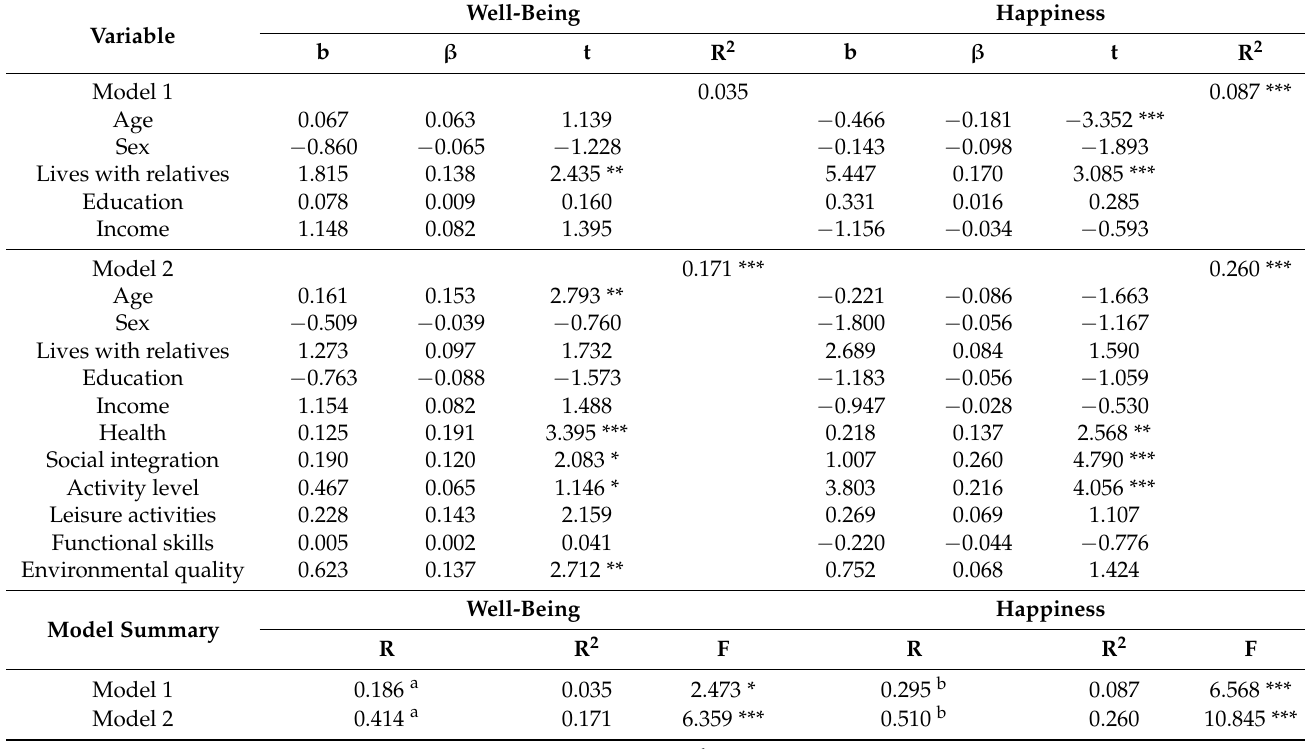
Table 4. Hierarchical multiple regression analysis for variables predicting wellbeing and